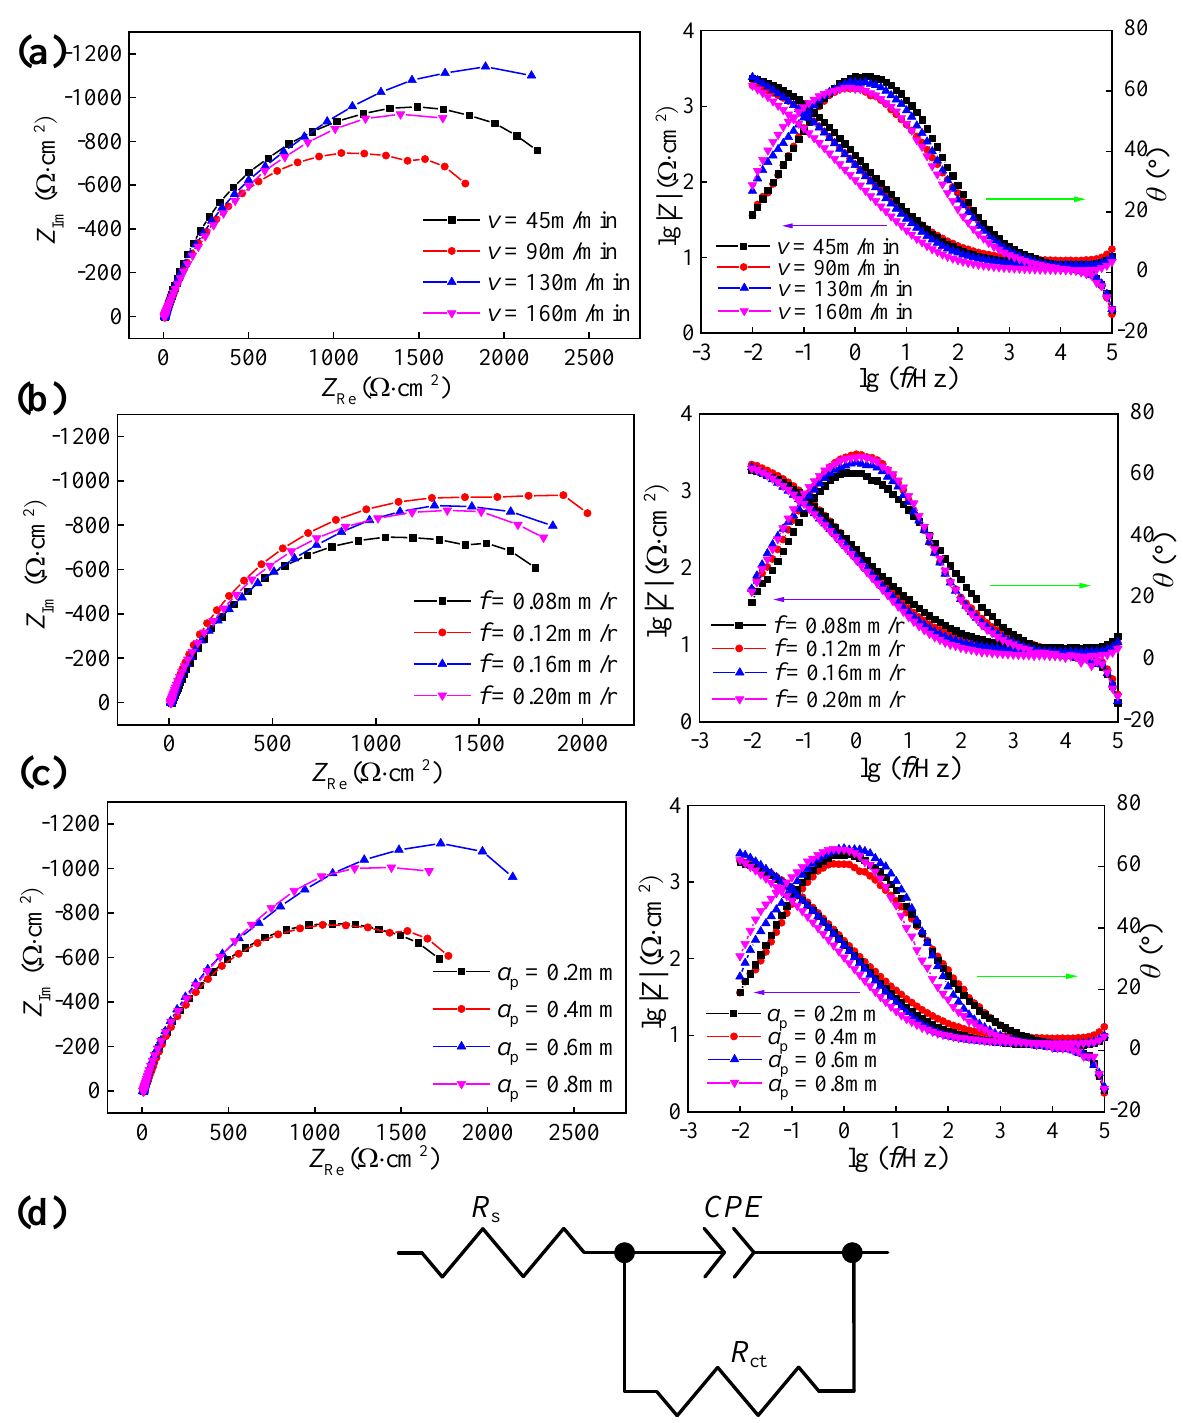
Figure 12. Nyquist plots and Bode plots of machined surfaces for samples machined under different cutting parameters: (a) cutting speed, (b) feed rate, and (c) cutting depth; and ( d ) equivalent circuit model of electrochemical impedance.